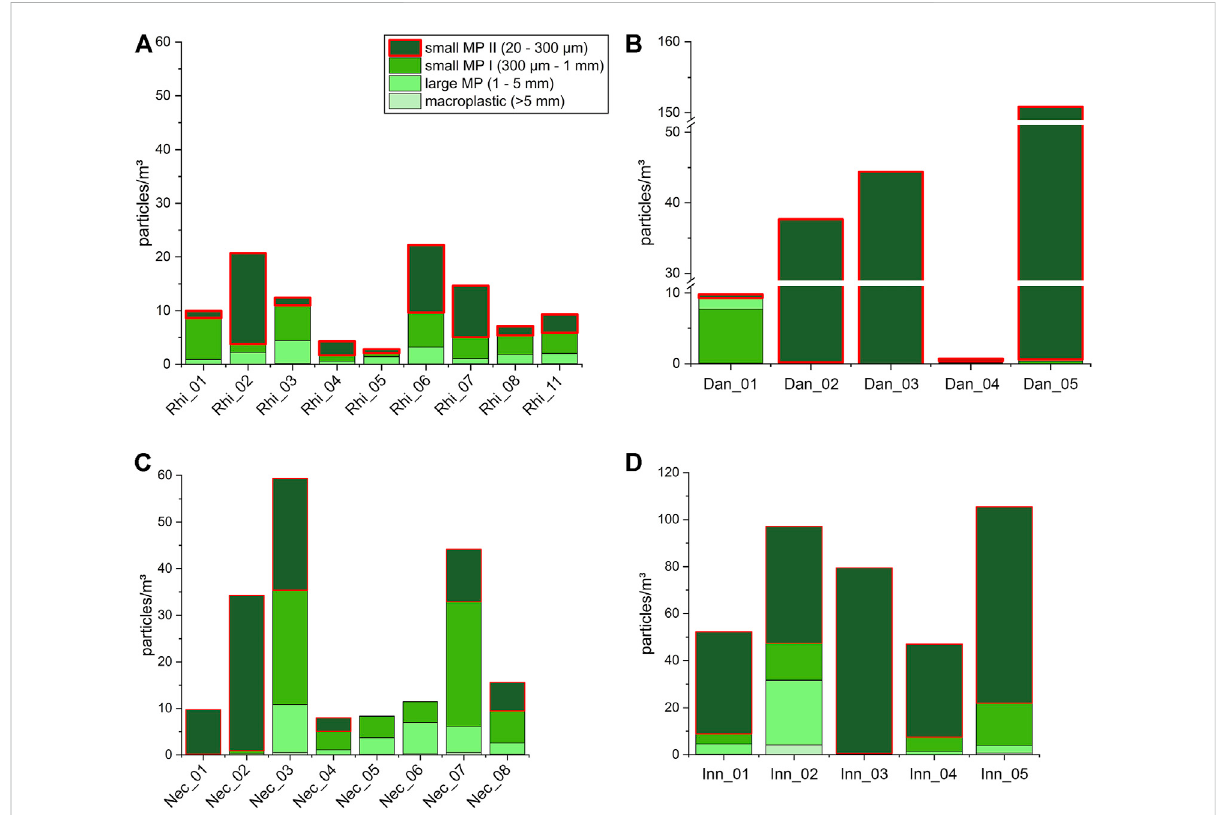
FIGURE 5 Large-scale sampling survey. Particle concentrations (number of particles/m 3 ) per size class (green scale) in the course of four rivers: (A) Rhine River and (C) it ’ s tributary Neckar River and (B) Danube River and (D) its tributary Inn River. The non-quantitatively sampled size class small MP II (20 – 300 μm) is marked with a red box to highlight the potential underestimation of particle abundance < 300 μm. Please note that the different scaling of y-axis changes to increase the readability.